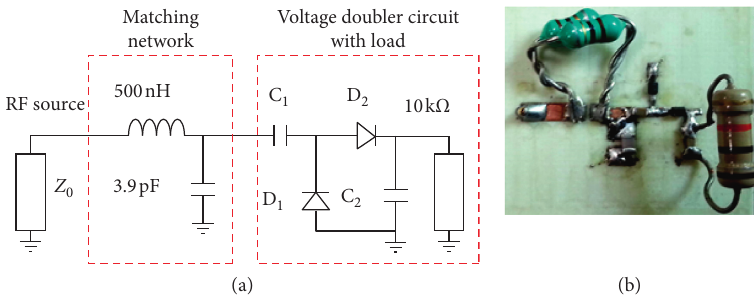
Figure 26: Schematic and prototype of FM rectifier (PCB size: 3.5 × 2.5cm 2 ).